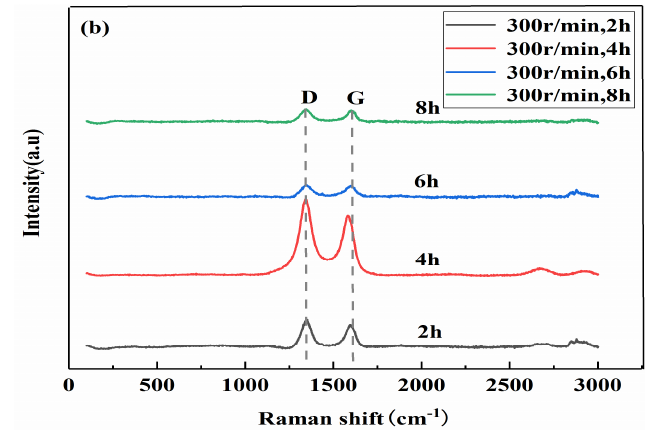
Figure 9. Raman spectrum of the cold-pressed composite. ( a ) 200 r/min; ( b ) 300 r/min.